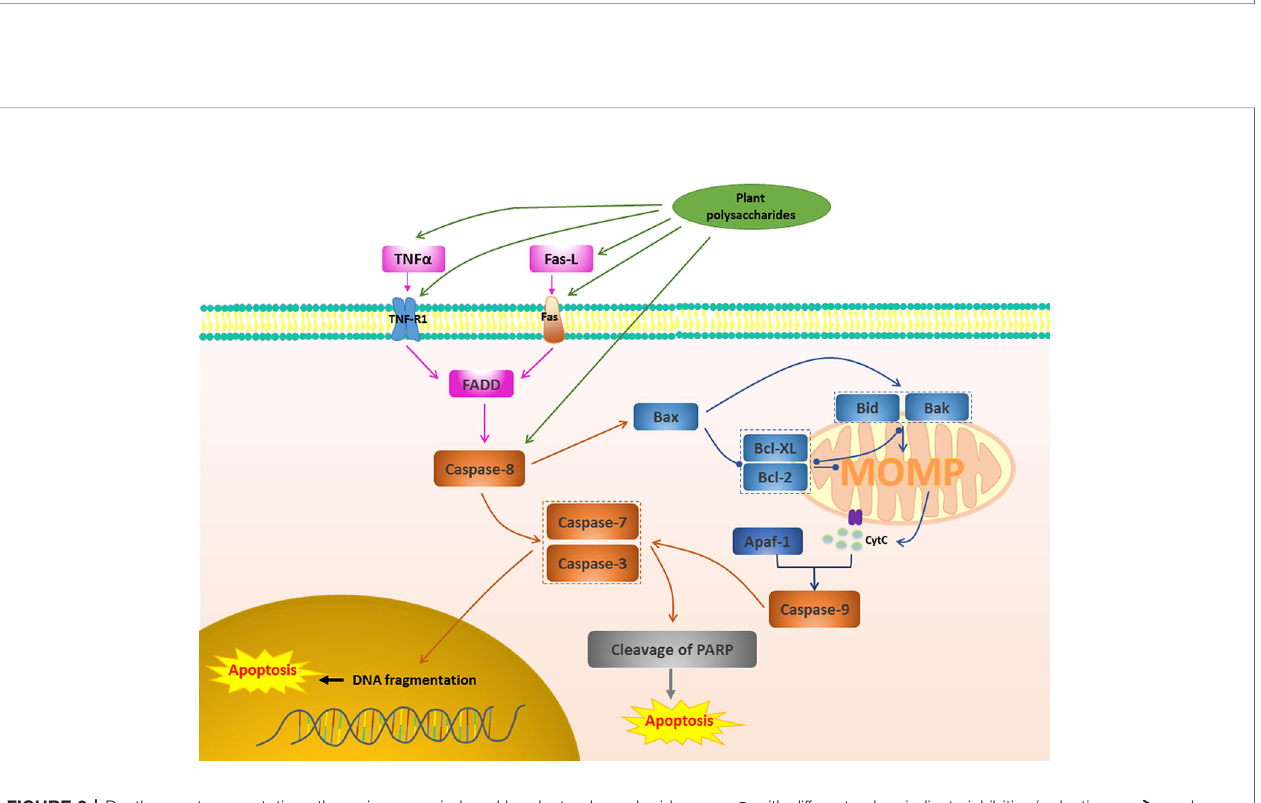
FIGURE 2 | Death receptor apoptotic pathway in cancer induced by plant polysaccharides. with different colors indicate inhibition/reduction, and with different colors indicate